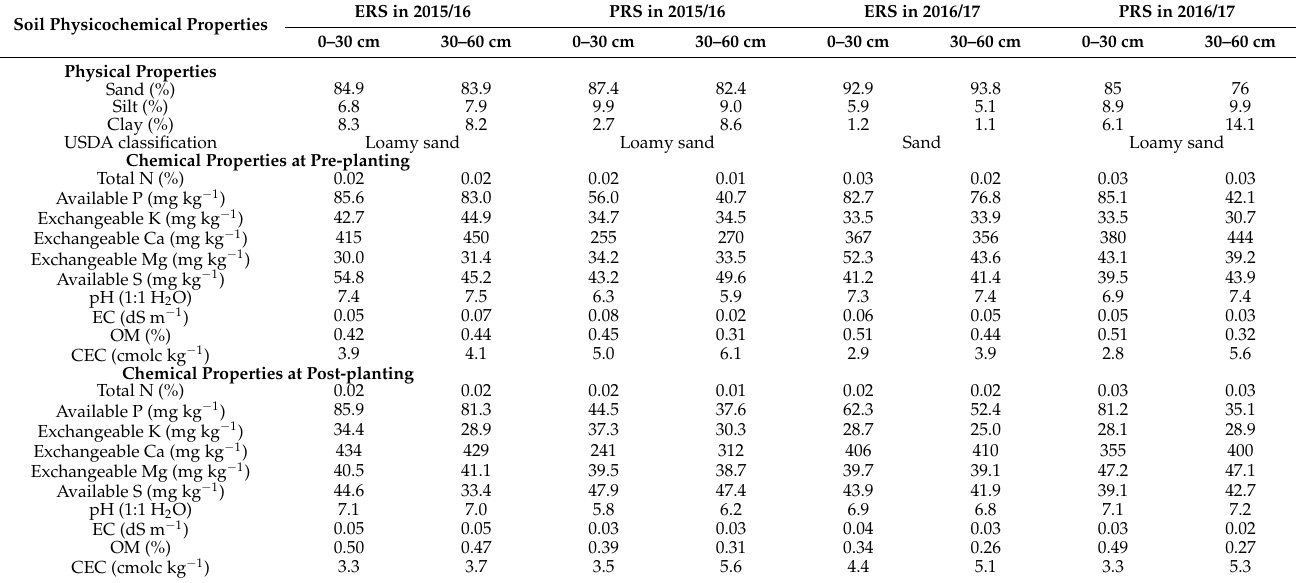
Table 2. Soil physicochemical properties at pre-planting and post-planting in the experimental fields at the depths 0–30 cm and 30–60